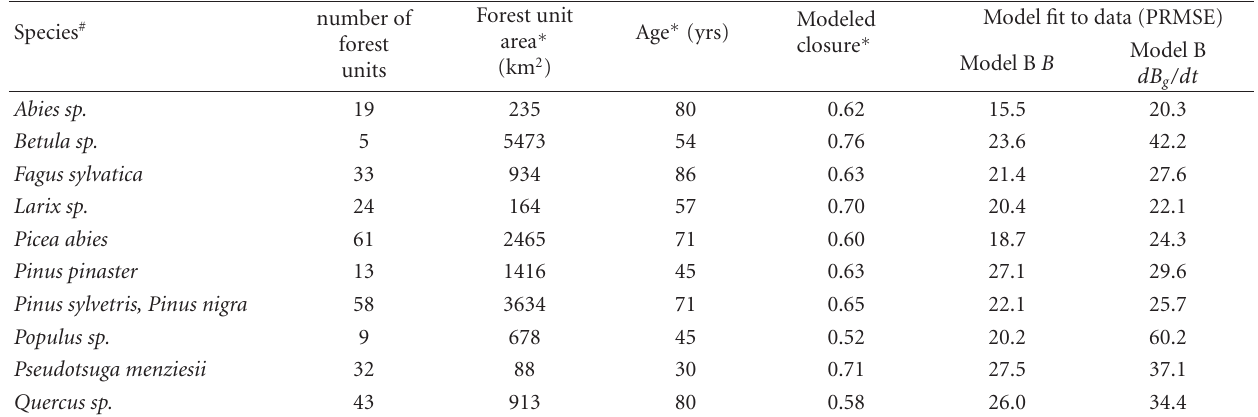
# species data in Table 2. ∗ values are means for each